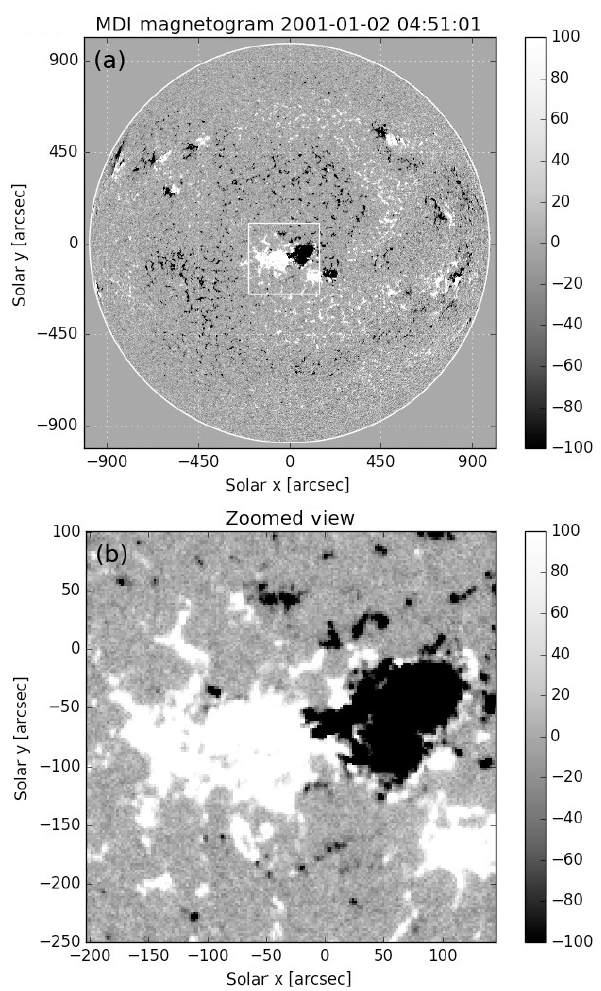
Figure 1. Full-disk LOS magnetic field (a) and close view of AR NOAA 9289 (b) as measured by the MDI–SoHO (SoHO – Solar and Heliospheric Observatory) instrument on 2 January 2001 at